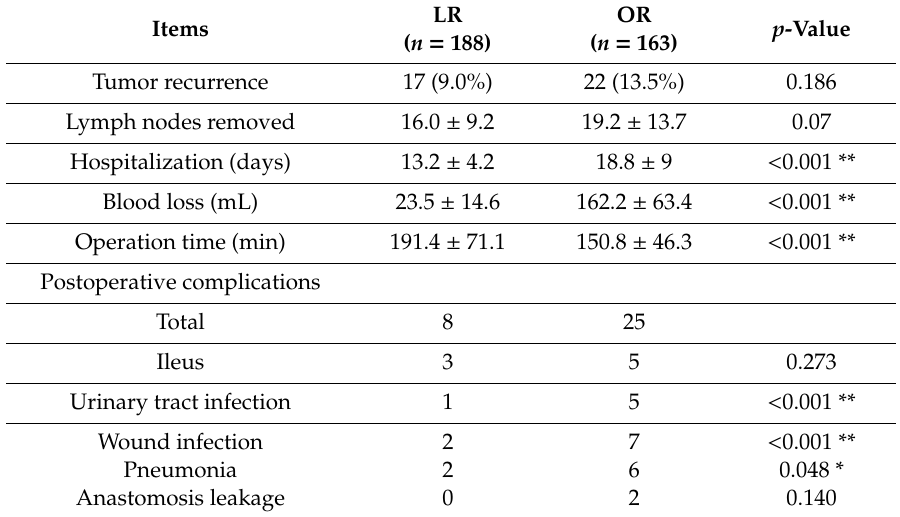
Table 2. Comparison of surgical outcomes between laparoscopic resection (LR) versus open resection (OR).